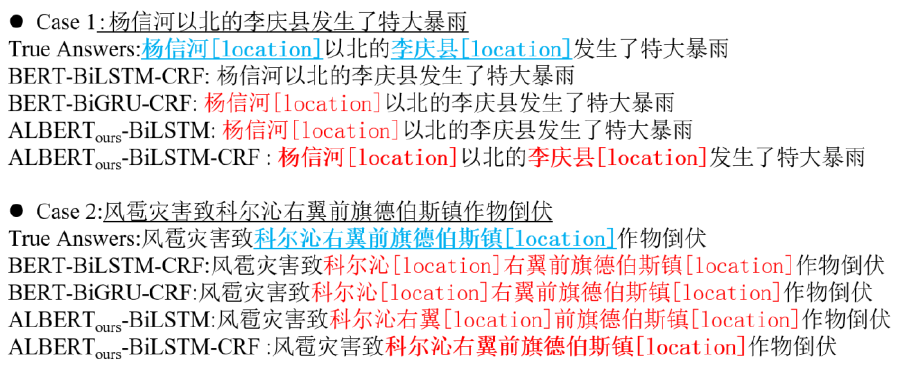
Figure 8. Error analysis of some typical cases. Blue represents standard place-name labeling, and red represents model identification place names. The translation of the sentence “ 杨信河以北的李庆县发生了特大暴雨 ” is “ Very heavy rainfall occurred in Liqing County north of Yang Xin River ”; the translation of the sentence “ 风雹灾害致科尔沁右翼前旗德伯斯镇作物倒伏 ” is “ Wind and hail disaster caused the Khorqin Right Wing Front Banner Debs town crop collapse ” .